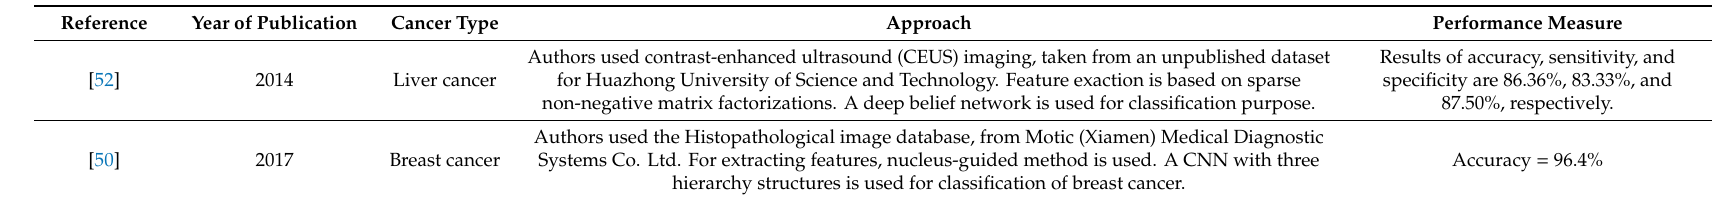
Table 2. The current state-of-the-art deep learning approaches for diagnosing cancers, including liver